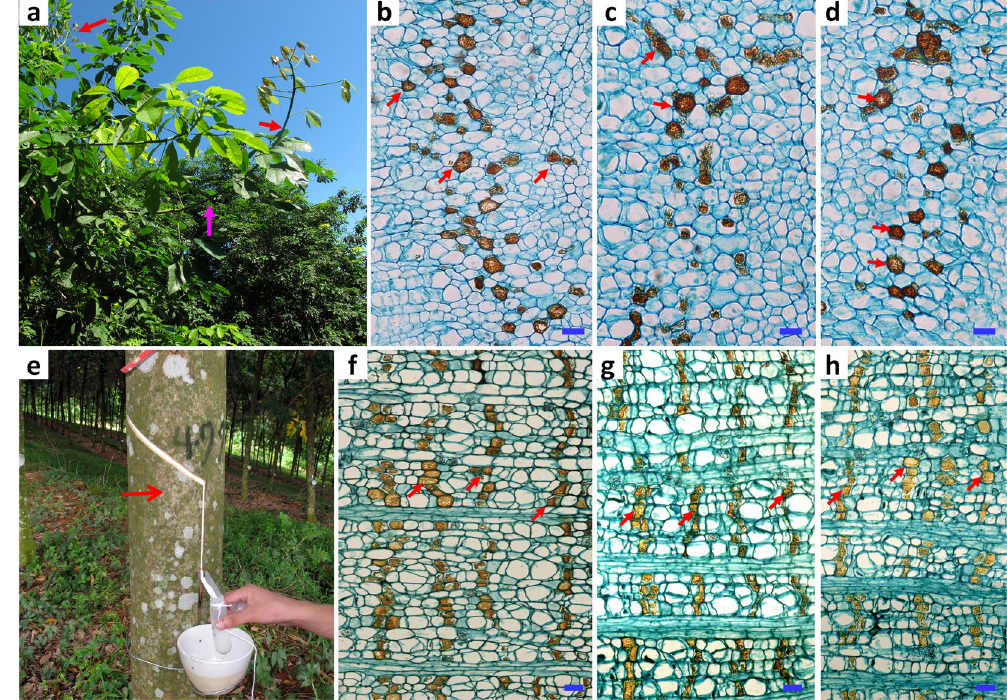
Figure 1. A comparison of the primary and the secondary laticifer cells in cross-sections. ( a ) Canopy of rubber tree clone RY7-33-97 (7-years old). Red arrows indicate the young shoots where the primary latex for RNA isolation and the bark samples for histological observation were collected, and the pink arrow indicates the region containing both the primary and the secondary laticifer cells. ( b – d ) Representative cross-sections of the bark of young shoots selected from three biological replicates. Red arrows indicate the primary laticifer cells. The scale bar represents 20 µ m; ( e ) A rubber tree trunk showing the latex in the first tapping. The red arrow indicates where the bark sample was collected for anatomical analysis. ( f – h ) Representative cross-sections of the bark from tree trunks showing the secondary laticifer cells; The scale bar represents 20 µ